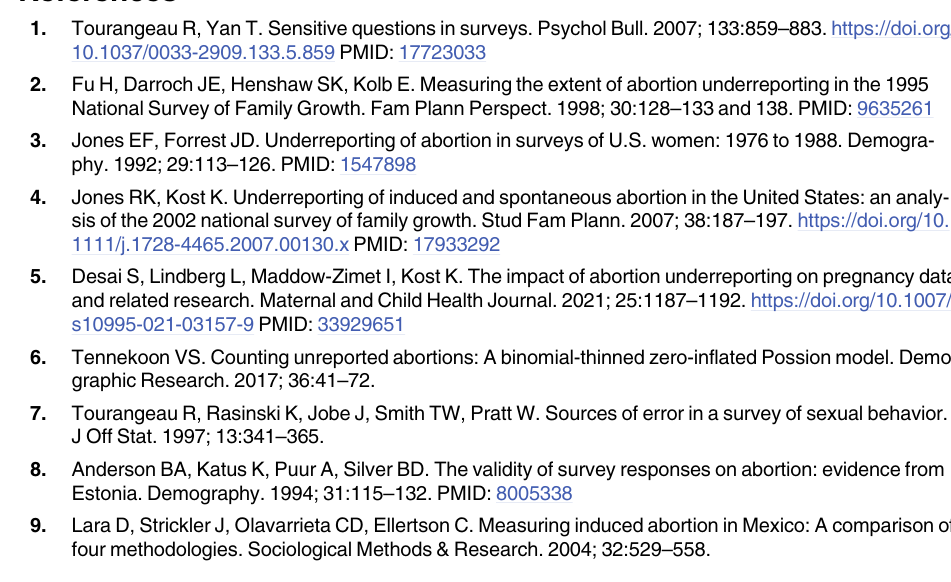
S3 Table. Results of logistic regression models predicting underreporting of abortion. S4 Table. Results of logistic regression models predicting underreporting of